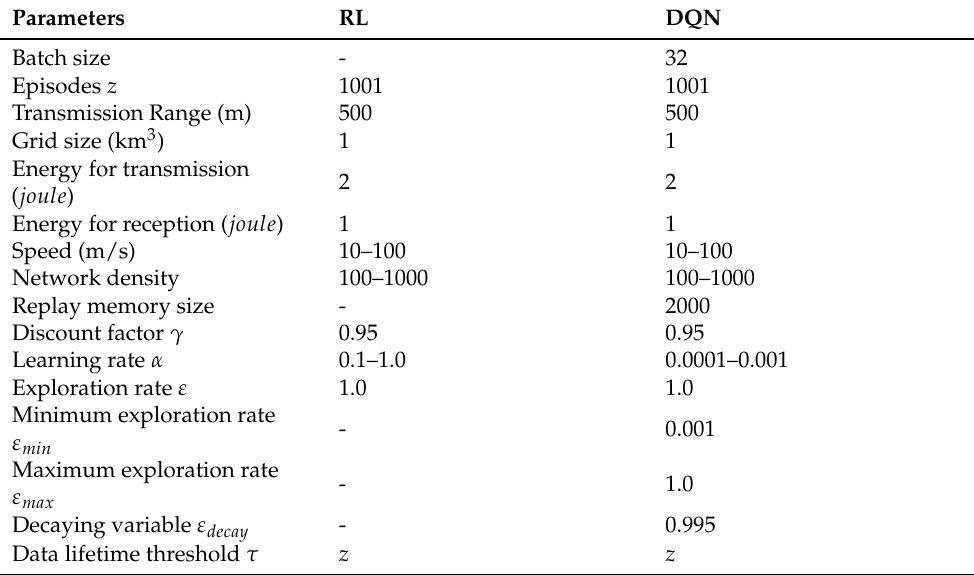
Table 6. Simulation parameters for the RL and DQN